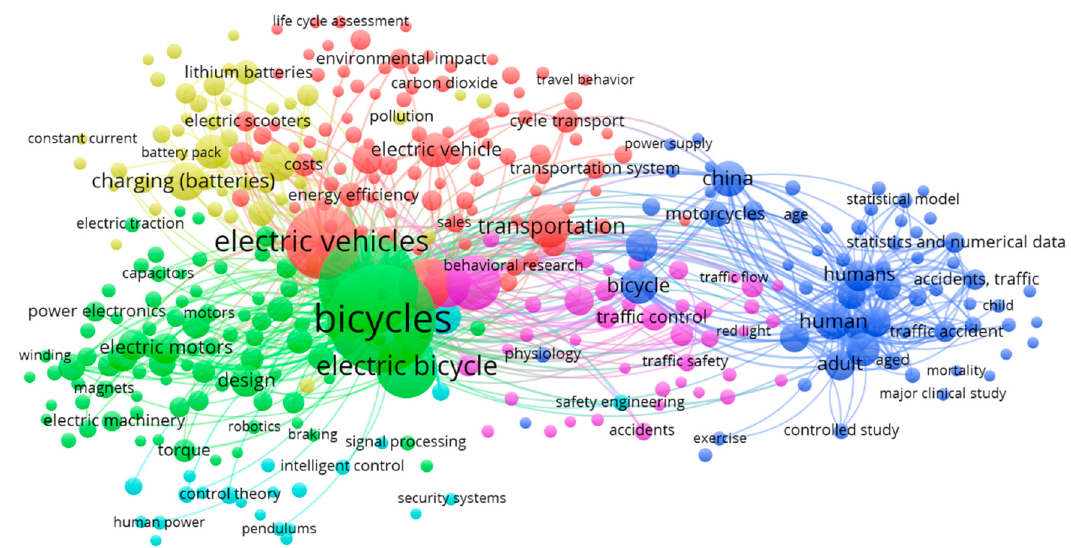
Figure 8. Electric bicycle Keywords network and their community detection.